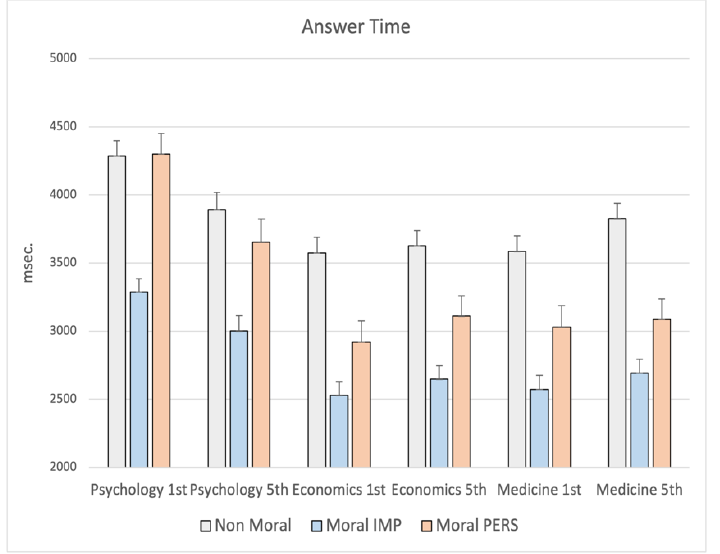
Figure 3. MANCOVA results on Answer Time: significant main effect for school. Note: the y-axis shows the answer time (msec.).